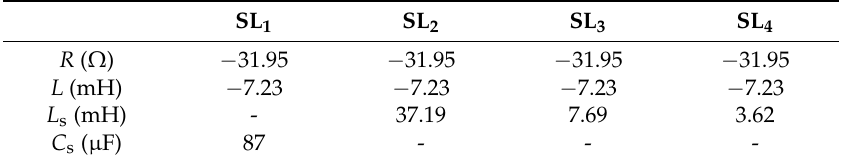
Table 2. Shunt circuit parameters used in the simulation of the shunted loudspeaker (SL)